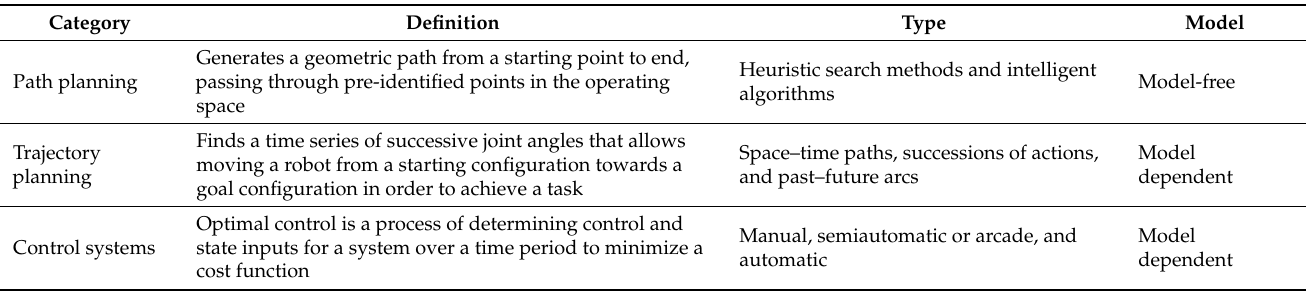
Table 1. Comparison of path planning, trajectory planning, and control